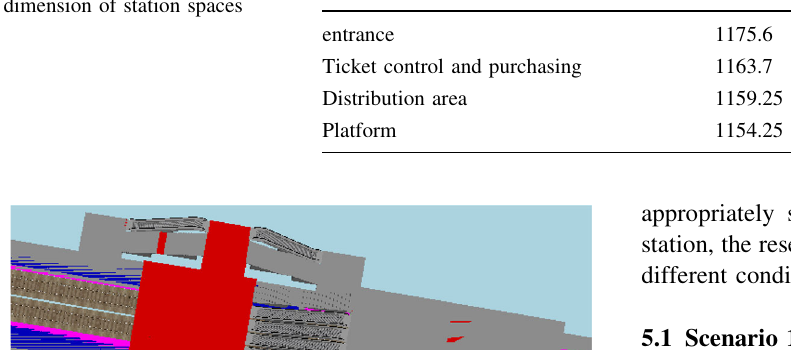
Table 2 Elevation and dimension of station spaces